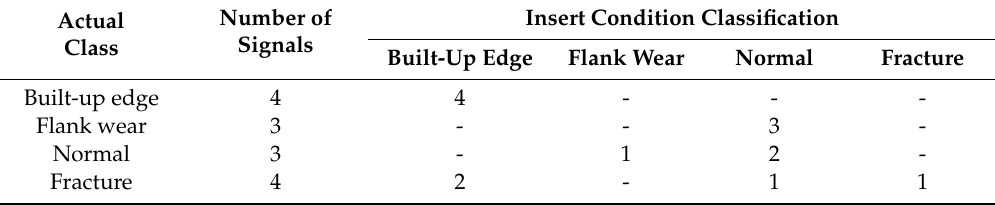
Table 10. Insert condition classification results. (cutting speed 306 m / min, depth of cut 1.1 mm, cutting feed 0.22 mm /